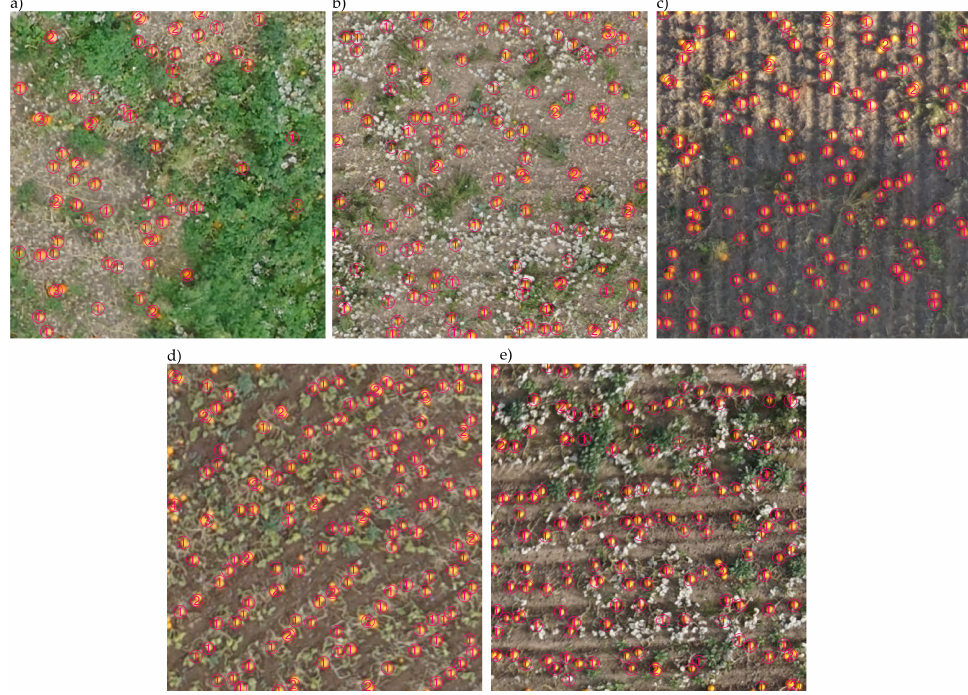
Figure 11. Sections of processing results for datasets G2017_102-1 ( a ), G2018_104-0 ( b ), G2019_106-0